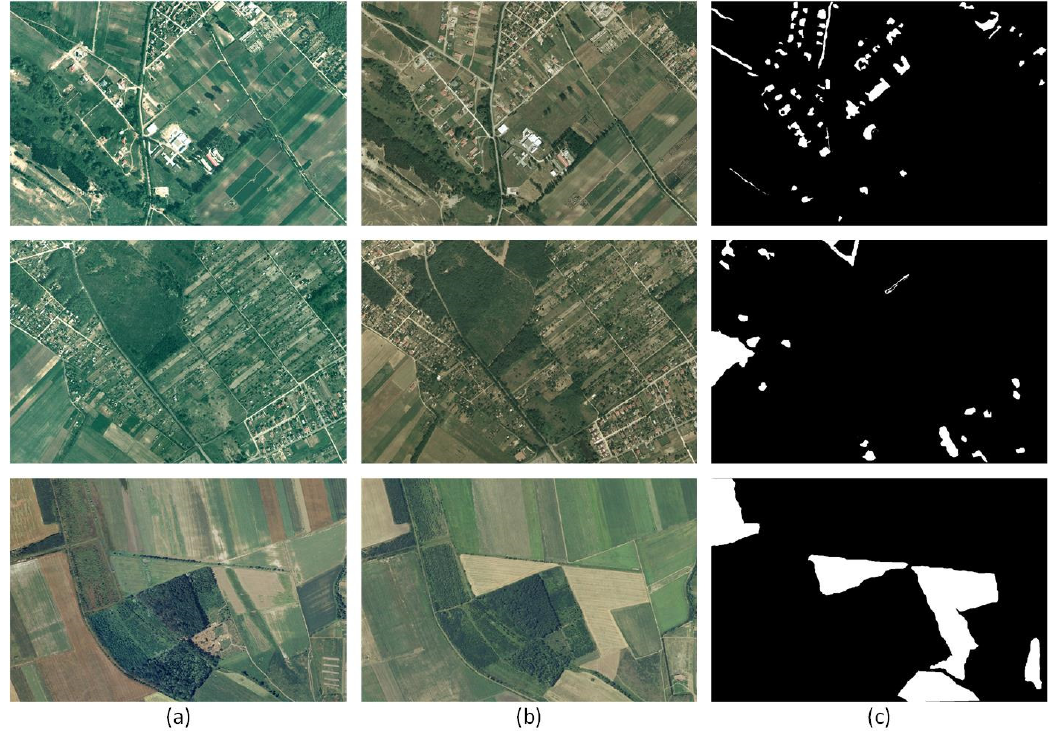
Figure 5. Sample image pairs and the corresponding change map references of SZTAKI benchmark: ( a ) images acquired at time T 1 , ( b ) Images acquired at time T 2 , ( c ) reference map.